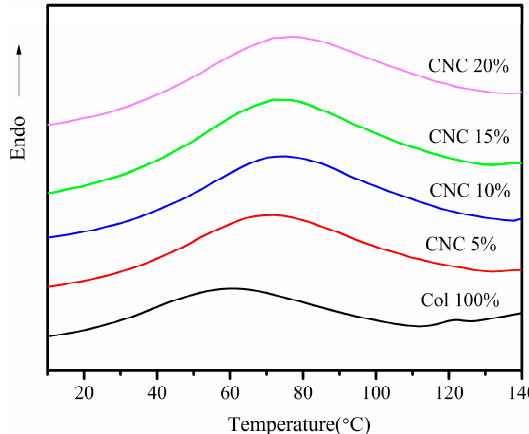
Figure 7. DSC curves of CNC/Col hydrogels.